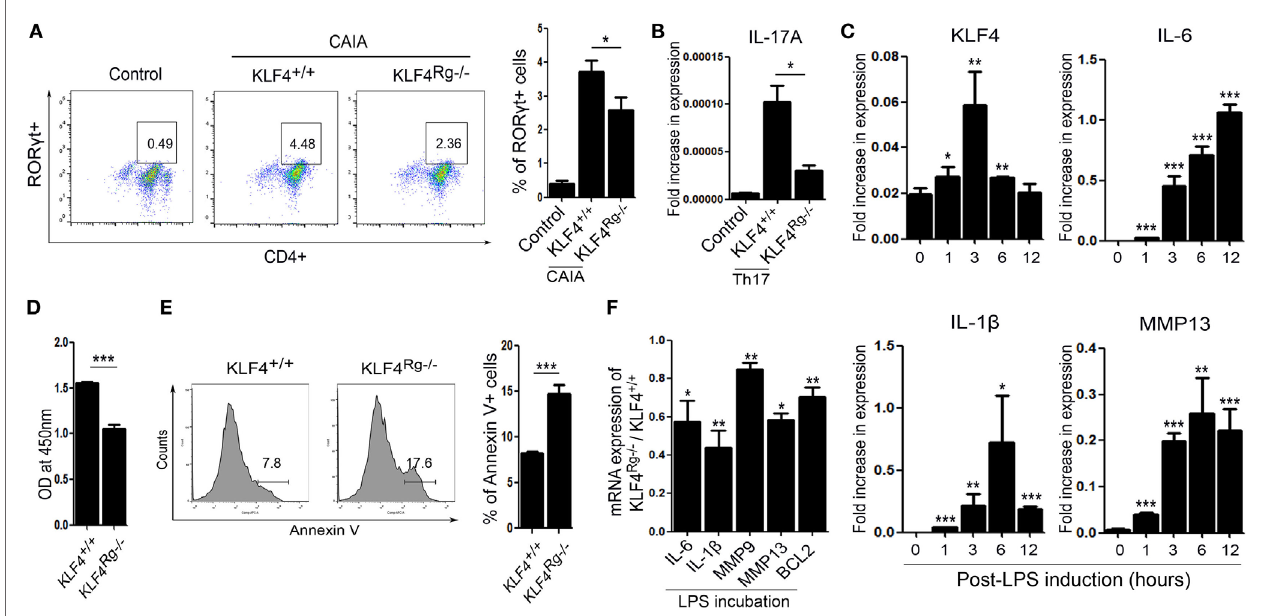
FigUre 5 | Kruppel-like factor (KLF) 4 affects autoimmune arthritis by regulating fibroblast-like synoviocyte (FLS) cell survival and inflammatory responses in vitro . (a) Left panel: representative flow cytometry plot showing the percentage of Th17 cells within the murine CD4 + T cell population sorted from splenocytes isolated from mice induced with collagen antibody (KLF4 + / + , KLF4 Rg − / − ) or not (control). Th17 cells were identified as CD4 + ROR γ t + . Right panel: average percentage of Th17 cells ( n = 4, control; n = 10, KLF4 + / + and KLF4 Rg − / − , each). (b) mRNA expression of IL-17A in Th0 (control) and Th17 (KLF4 + / + , KLF4 Rg − / − ) differentiated CD4 + T cells ( n = 3). (c) Expression of mRNA encoding KLF4, interleukin (IL)-6, IL-1 β , and matrix metallopeptidase 13 (MMP13) in control and lipopolysaccharide (LPS)-treated murine FLS [as measured by real-time quantitative polymerase chain reaction (q-PCR), n = 4]. (D) Proliferation of KLF4 + / + and KLF4 Rg − / − FLS (as measured in a CCK-8 assay). (e) Representative flow cytometry plots showing Annexin V-stained FLS from KLF4 + / + and KLF4 Rg − / − mice ( n = 4). (F) Ratio of mRNA encoding IL-6, IL-1 β , MMP9, MMP13, or BCL2 in FLS from KLF4 Rg − / − mice to that in FLS from KLF4 + / + mice with LPS treat for 24 h (as measured by real-time q-PCR, n = 3). Values are expressed as the mean ± SEM (* P < 0.05, ** P < 0.01, and *** P < 0.001). Values in panel (c) are generated from a comparison between control (0 h) and LPS-treated murine